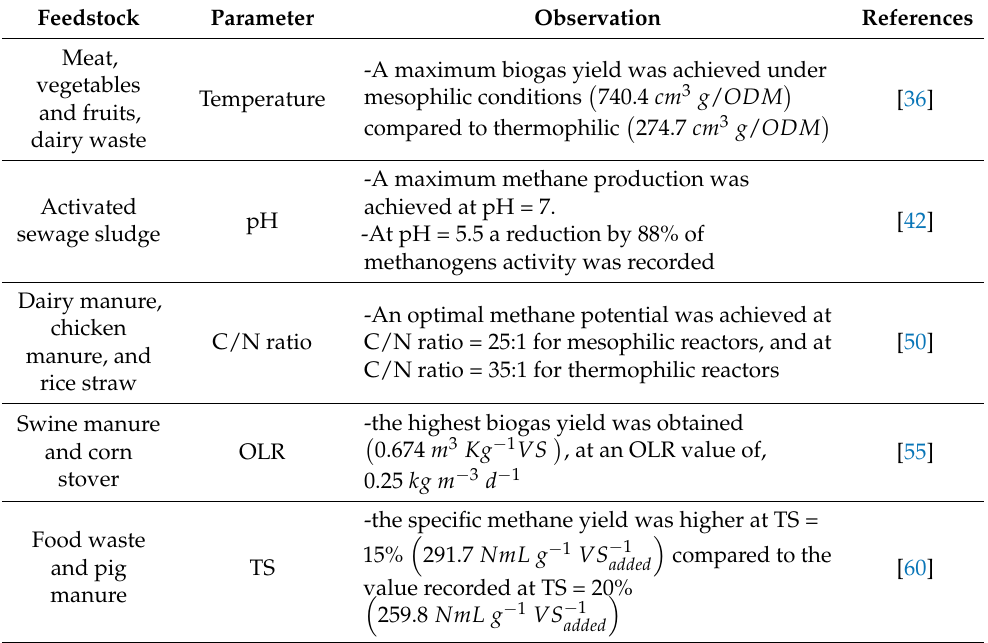
Table 2. The effect of different parameters on the biogas